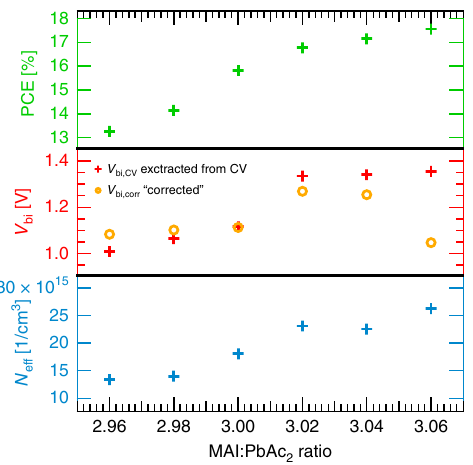
Fig. 1 Capacitance – voltage parameters in comparison to PCE. The dependence of power conversion ef fi ciency PCE (green), built-in potential V N bi (red) and effective doping density eff (blue) on stoichiometry (MAI:PbAc 2 ) of the precursor solution is shown. PCE values are taken from Supplementary Fig. 2 for comparison. V bi can be corrected (yellow circles) by estimating the potential drop caused by mobile ions at the interfaces.